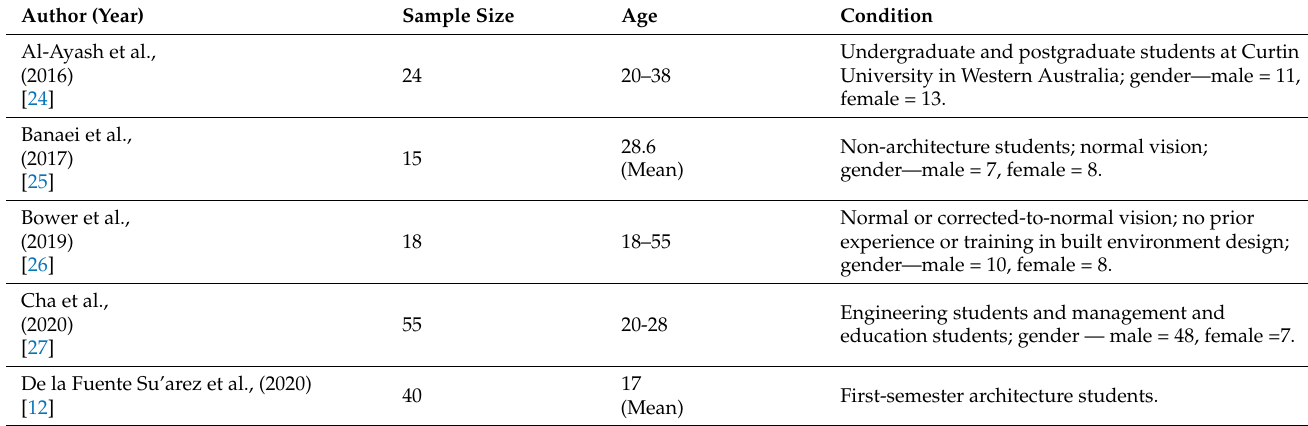
Table 2. Characteristics of